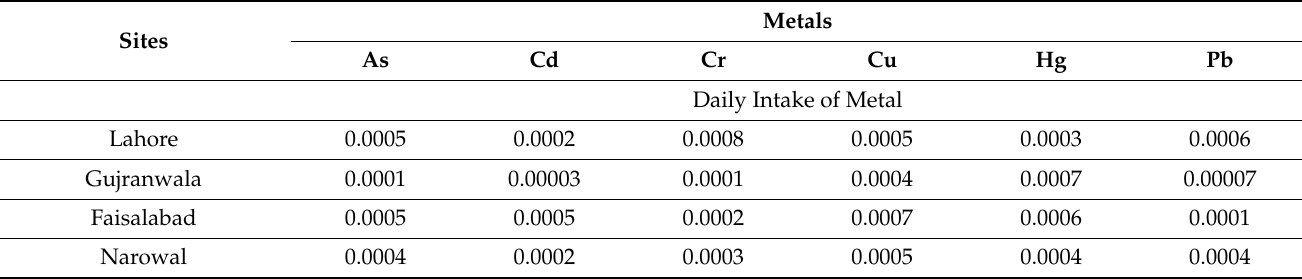
Table 3. Daily intake of metal and health risk index of rice in selected